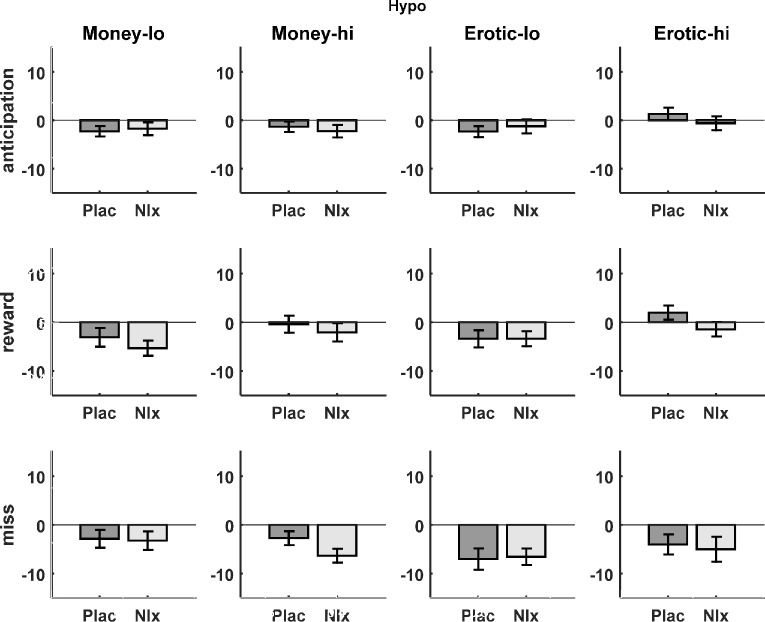
Hypothalamus fMRI responses (arbitrary units) for all stimuli (money/erotic, high/low) and time-points (anticipation, outcome: reward, outcome: miss) under placebo (Plac) and naloxone (Nlx).Error bars represent standard error of the mean.